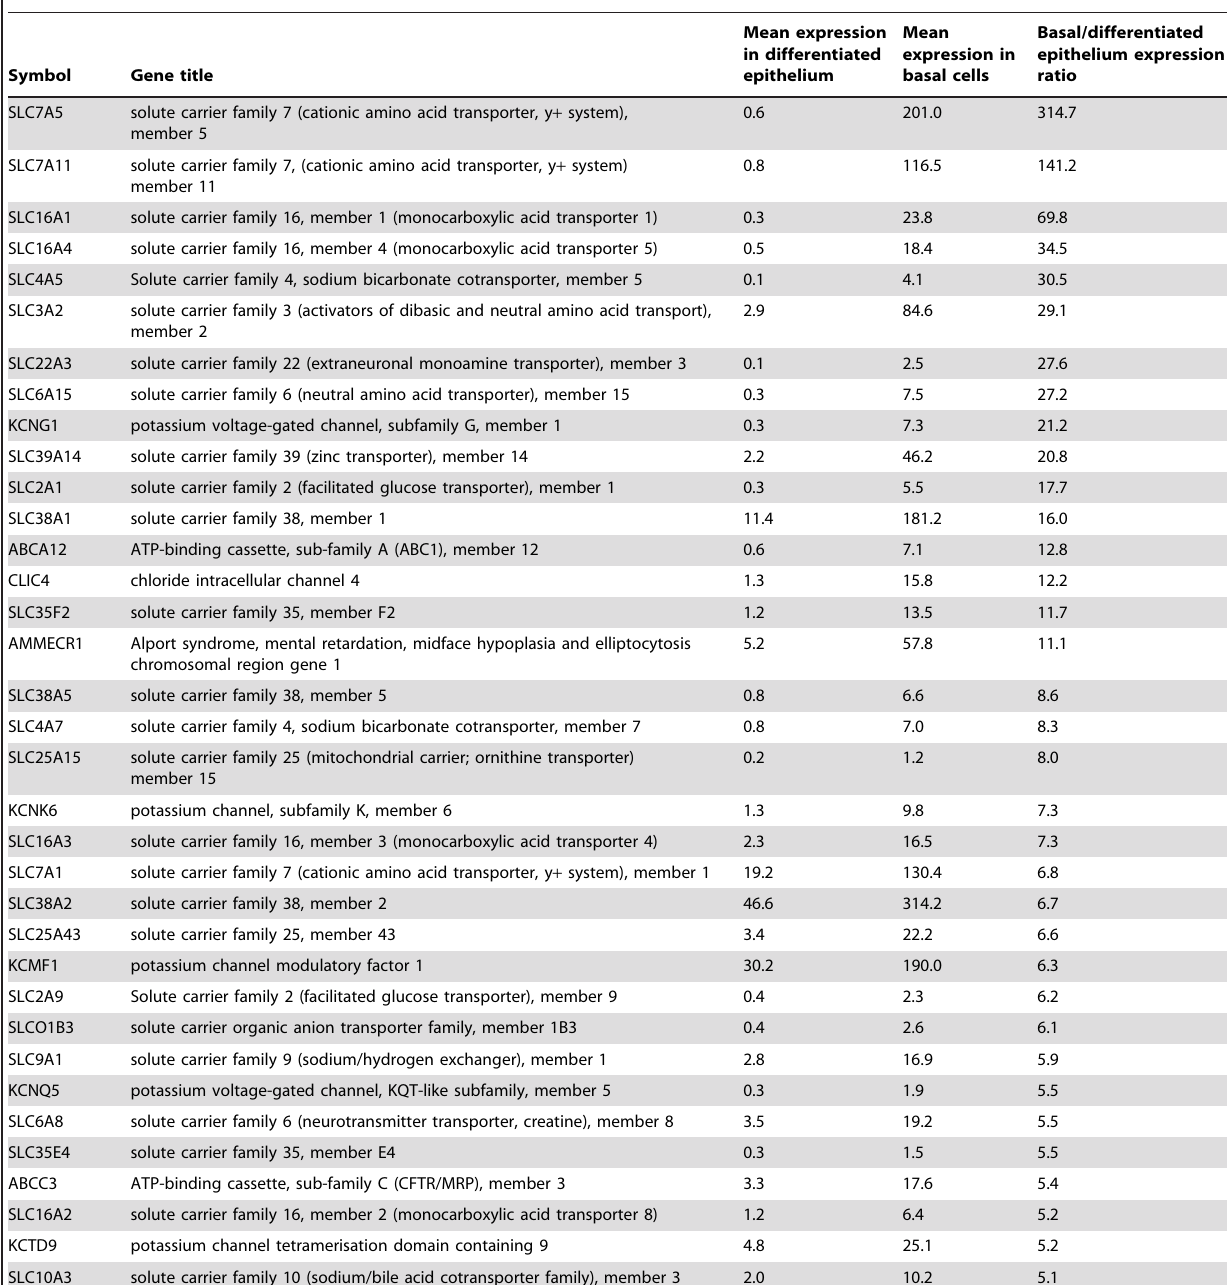
1 Genes identified by GATHER KEGG categories (Table 2, Table S3), Gene Ontology categories (Table 3, Table S5), and/or Canonical Pathways (Table 4, Table S6).